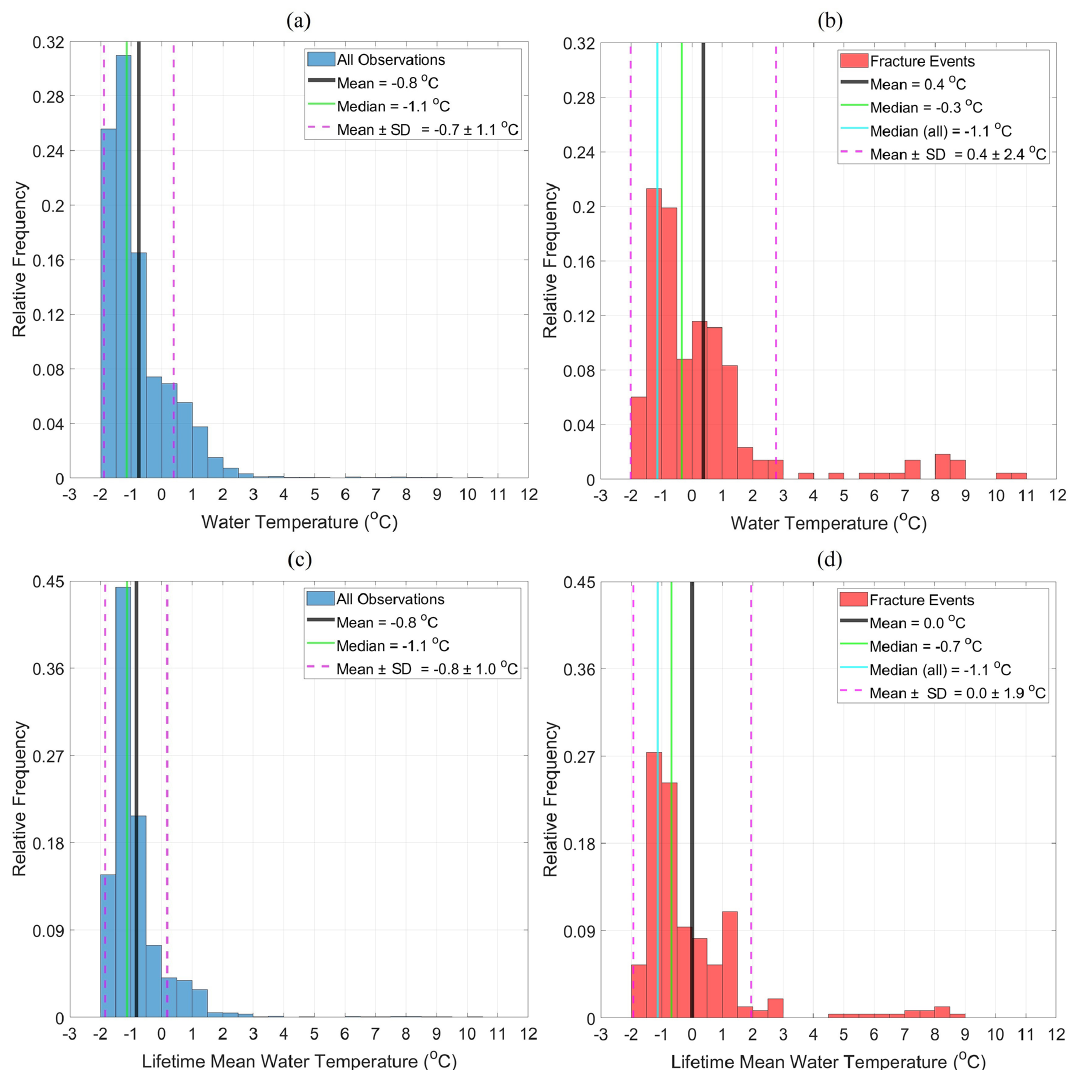
Figure 3. Relative frequency histogram plots of water temperature ( a ; n = 16784, b ; n = 298) and lifetime mean water temperature ( c ; n = 13537, d ; n = 256) surrounding the Petermann ice islands for all observations (a, c) and for the fracture events (b, d)